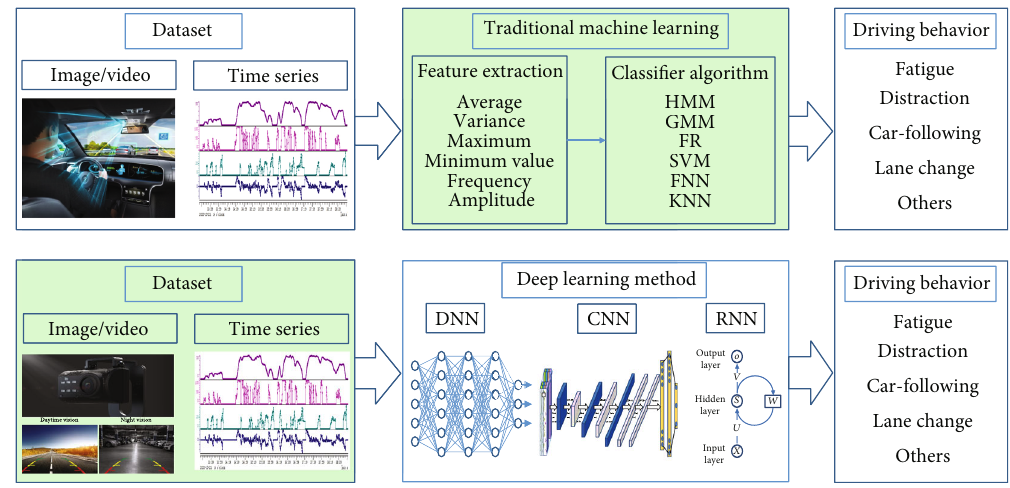
Figure 1: The common recognition methods of driving